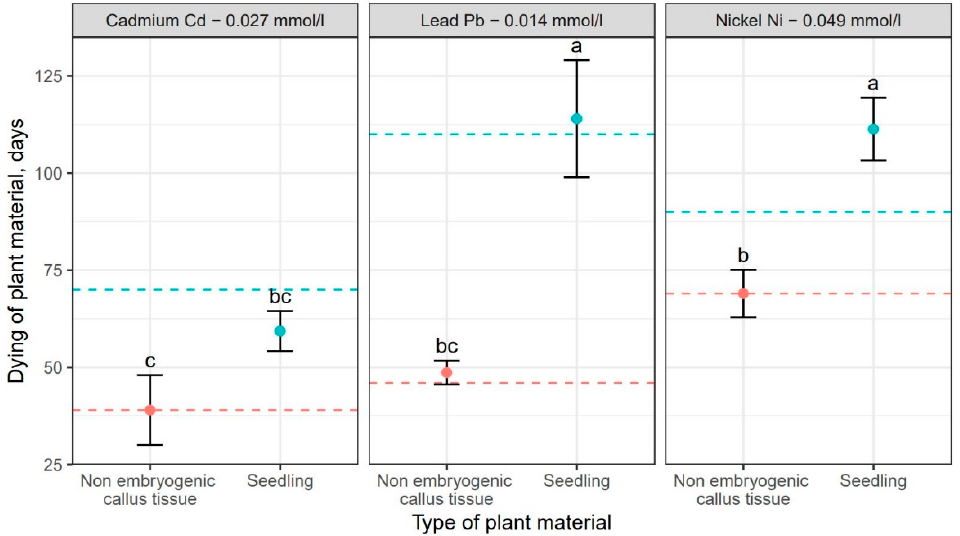
Table 3. Average time required for heavy metal additions to cause complete dieback of F. excelsior seedlings and callus cultures. The same letters indicate lack of statistically significant differences ( p < 0.05), only the letters marked with the same number should be compared.